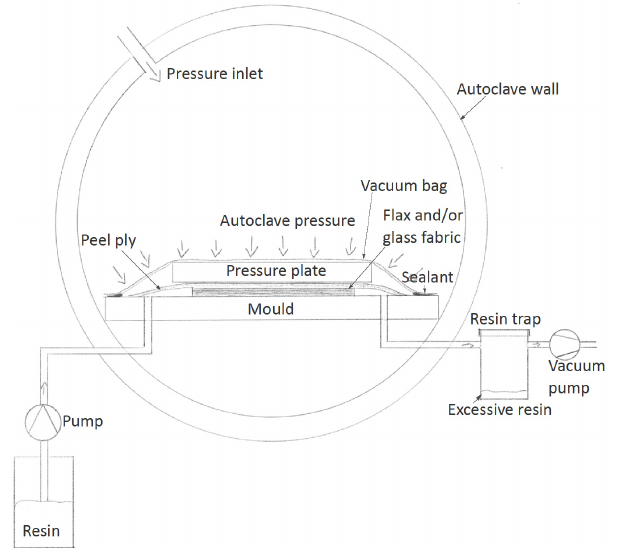
Figure 2. Schematic representation of the resin injection process in the autoclave (autoclave injection).